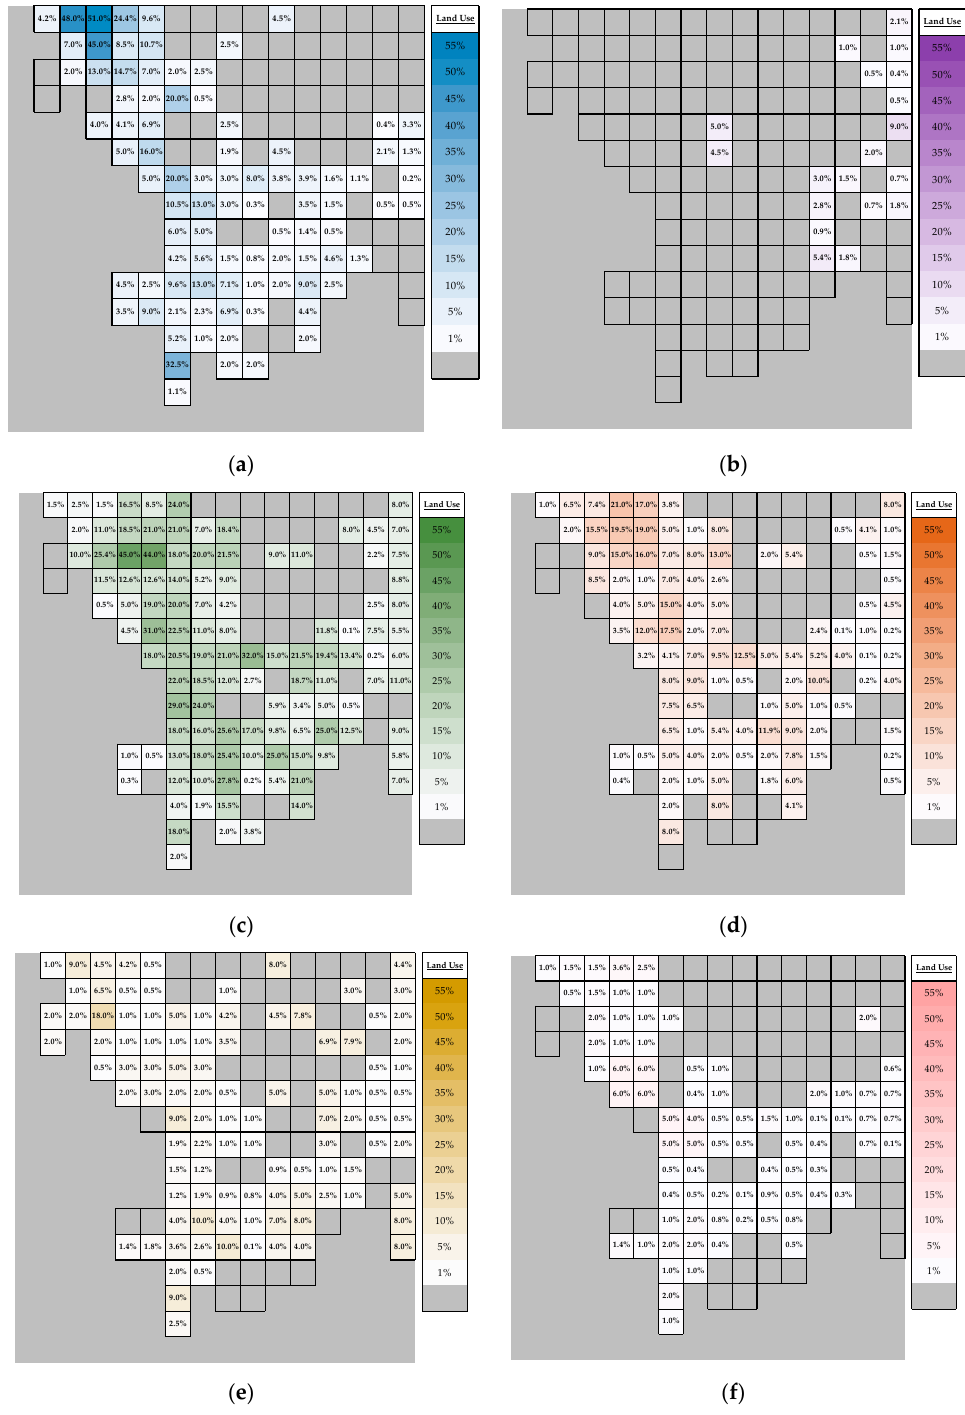
Figure A1. Current land use as percentage (%) of the small area’s size ( a ) sum of business and commercial land use; ( b ) industrial land use; ( c ) low residential land use; ( d ) high residential land use; ( e ) sum of governmental and utilities land use; ( f ) transportation land use. Figure A2 presents the future land use for the last year of the forecasting horizon (year 2019), for each type of land